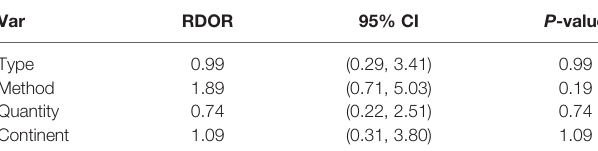
TABLE 2 | RDOR and P -values of covariants in the meta-regression analysis.